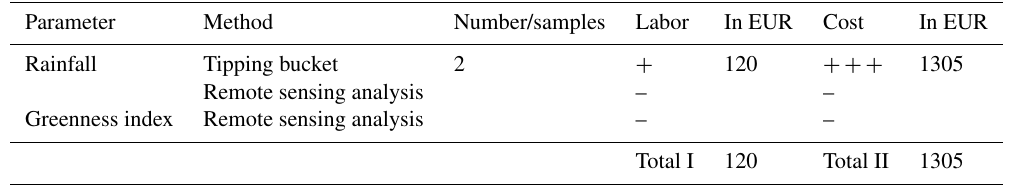
Table A4. Kenya case, scenario 1: to use remote sensing data. Parameter